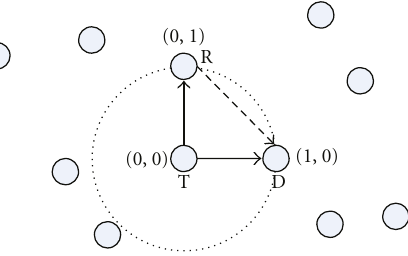
Figure 12: Three ad hoc nodes (transmitter, relay, and destination) using PSO-aided adaptive